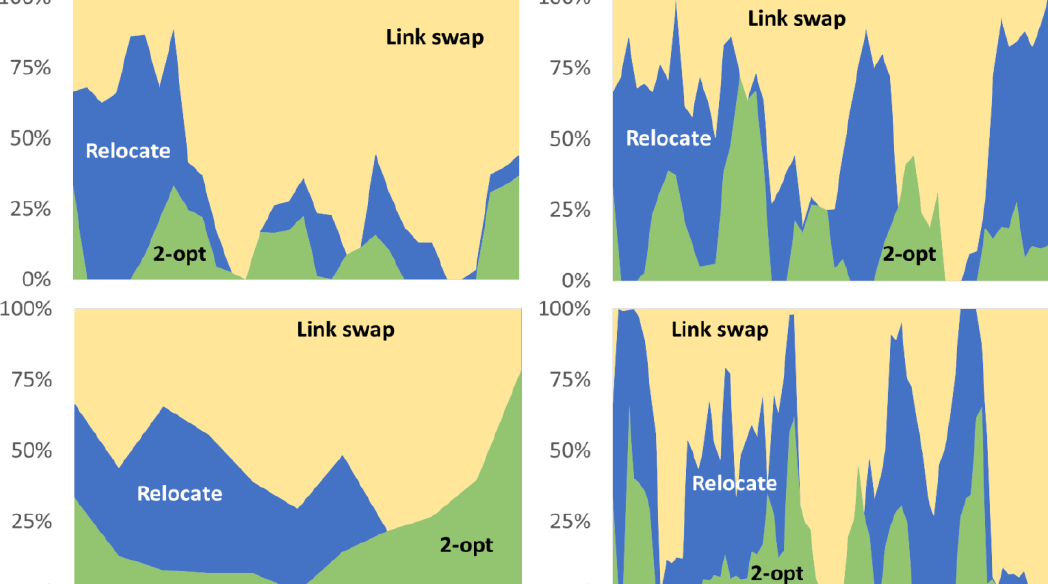
Appl. Sci. 2019 , 9 , x FOR PEER REVIEW Figure 23. Screenshots of the 4 different O – Mopsi instances (in the same order). Figure 23. Screenshots of the 4 di ff erent O–Mopsi instances (in the same order).